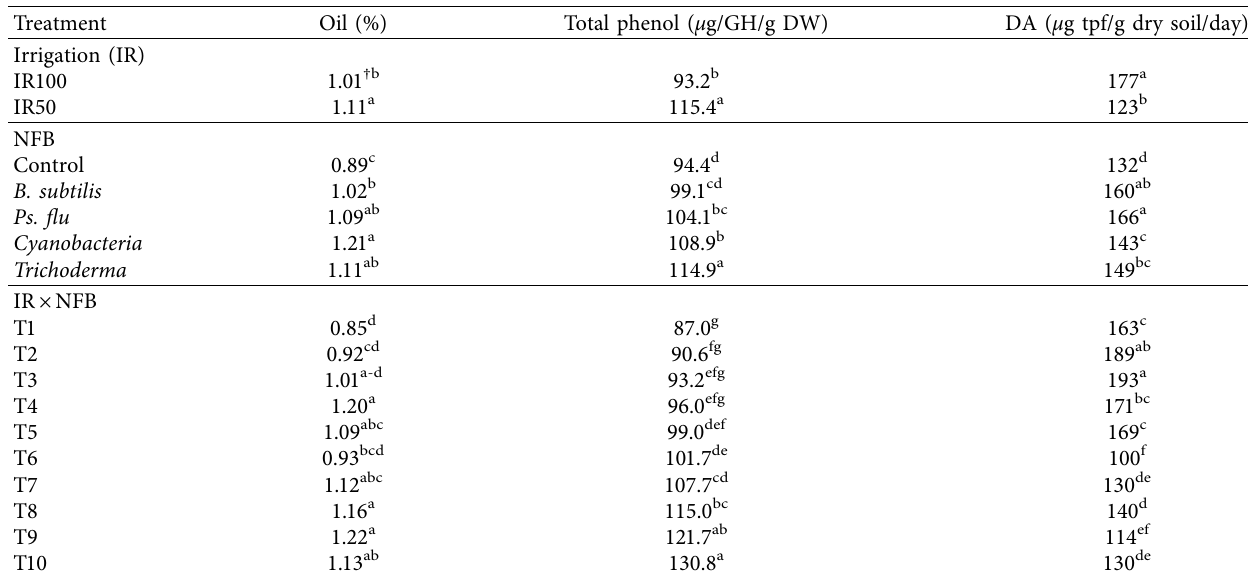
Table 3: Effects of nitrogen-fixing bacteria (NFB) on oil (%), total phenol ( µ g/GH/g DW), and dehydrogenase activity (DA) ( µ g Tpf/g dry